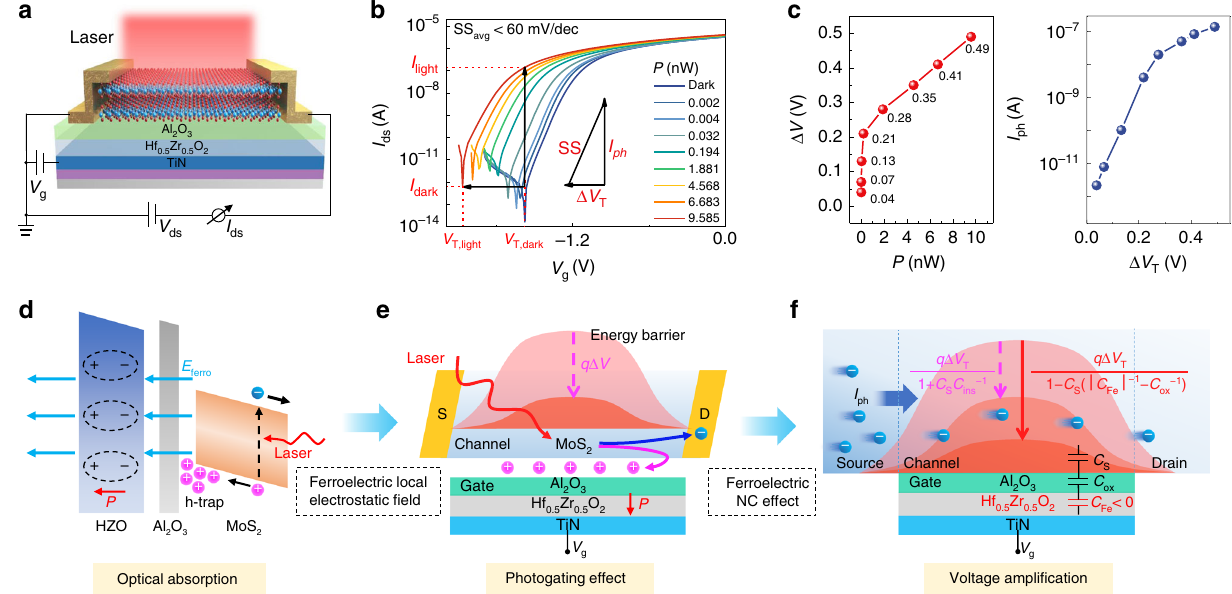
Fig. 3 Mechanism of ultrasensitive optical detection in the NC MoS 2 phototransistors. a Laser is incident perpendicularly to the device surface, and the spot covers the entire channel uniformly. b V g – I ds curves at V ds = 0.5 V in the dark and under various incident light powers ( λ = 520 nm). c Dependence of threshold shifts on the incident optical powers and dependence of photocurrent on threshold shifts are extracted from V g – I ds curves. d Under light illumination, enhanced light absorption can be achieved in multilayer MoS 2 , generating electron-hole pairs ef fi ciently by a strong light-matter interaction. e Photoexcited electrons are pulled toward the electrodes, while photoexcited holes are trapped in the gate stack due to the ferroelectric electrostatic local fi eld, leading to strong photogating effect on the phototransistors. Photogating effect gives rise to a threshold shift as well as a reduction of the energy barrier in the channel ( q Δ V ), so that more electrons can get over the energy barrier and forms photocurrent. f In generally, q Δ V = q Δ V T (1 + C S C ins − 1 ) − 1 < q Δ V C T since the total capacitance of gate insulators ( ins ) is usually positive. However, MoS 2 NC phototransistors can break through this limitation